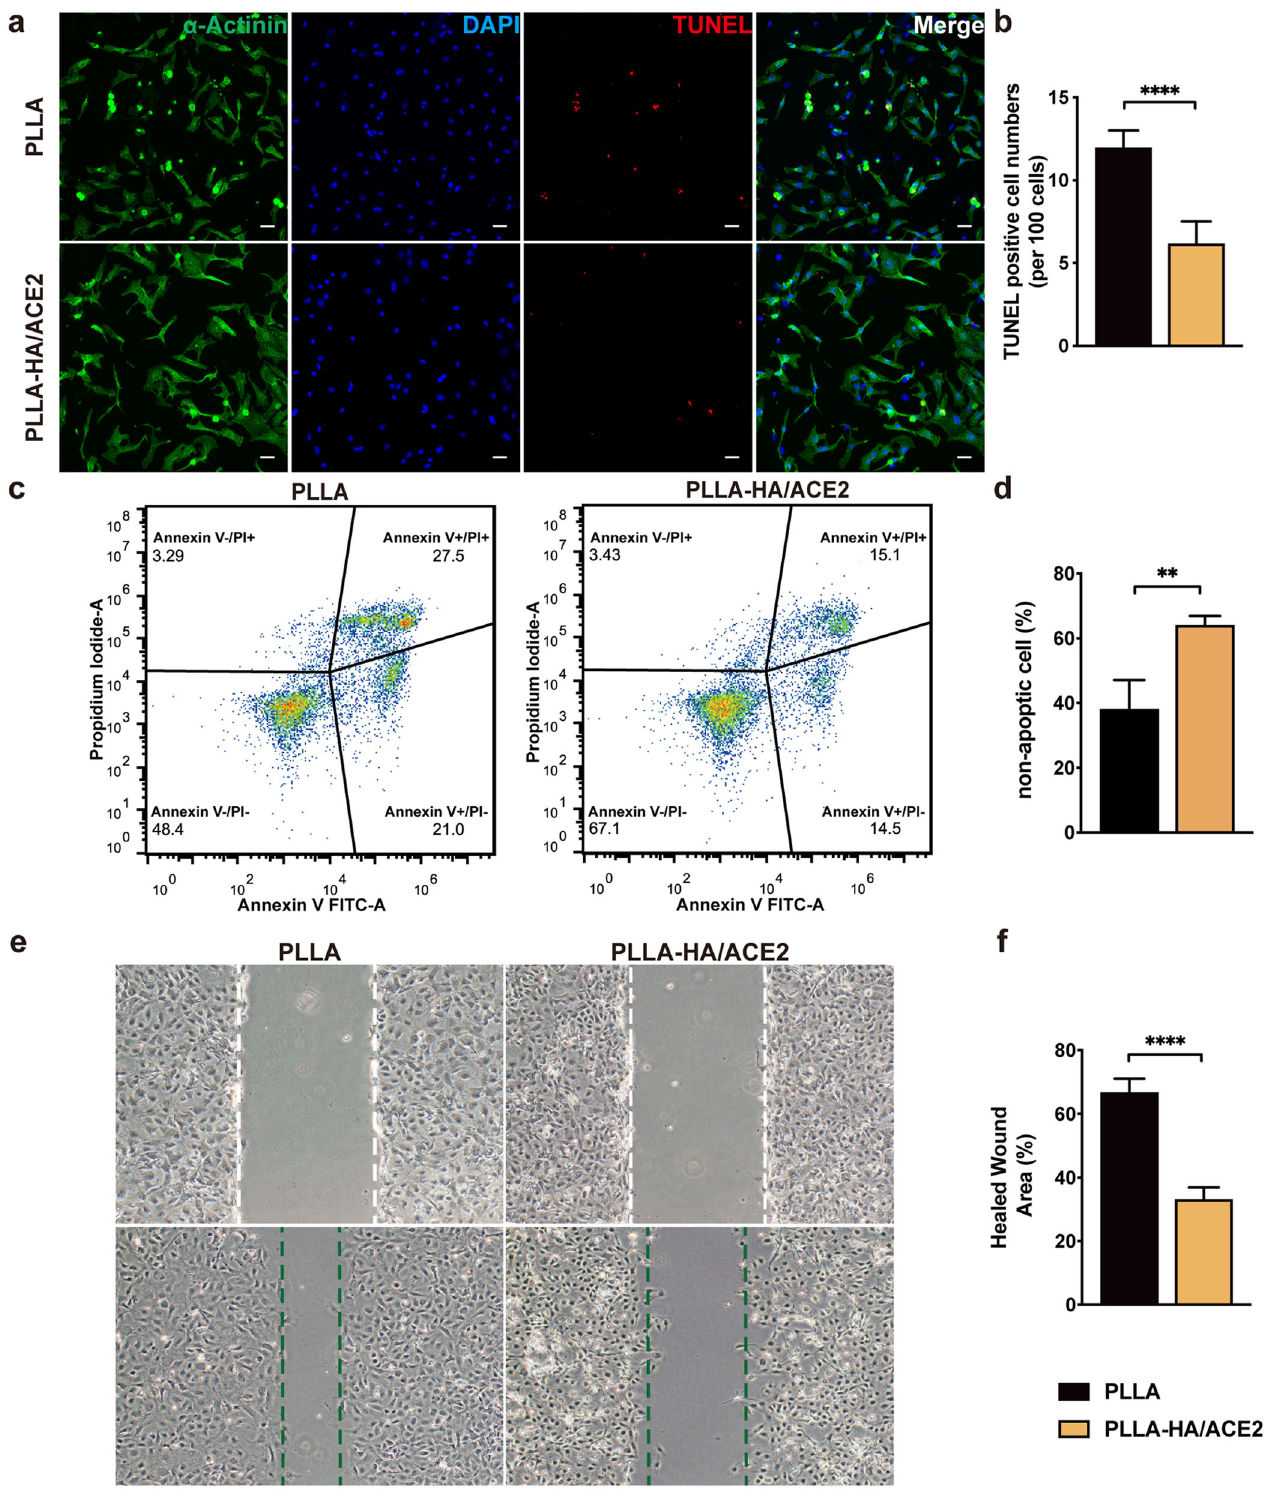
Fig. 4 Effects of rhACE2 patch on neonatal rat cardiomyocytes (NRCMs) and cardiac fi broblasts in vitro. a Representative immuno fl uorescence staining of NRCMs exposed to 6 h hypoxia and cocultured with different patches was observed with α -actinin antibody (green), DAPI (blue), and TUNEL (red). Scale bars represented 50 μ m. b Statistical analysis of TUNEL-positive cell counts per 100 cells. n = 5/group. c Representative fl ow cytometric Annexin V FITC-A vs Propidium Iodide-A quad plots of NRCMs after 6 h hypoxia treatment. d The percentage of Annexin V − /PI − cell were summarized. n = 3/group. e Representative wound healing assay image of cardiac fi broblasts cocultured with different patches after 24 h. f Statistical analysis of healed wound area difference between two groups. n = 5/group. Data were represented as the mean ± SEM. Two group comparisons were analyzed by the unpaired Student ’ s t -test; ** P < 0.01, **** P <